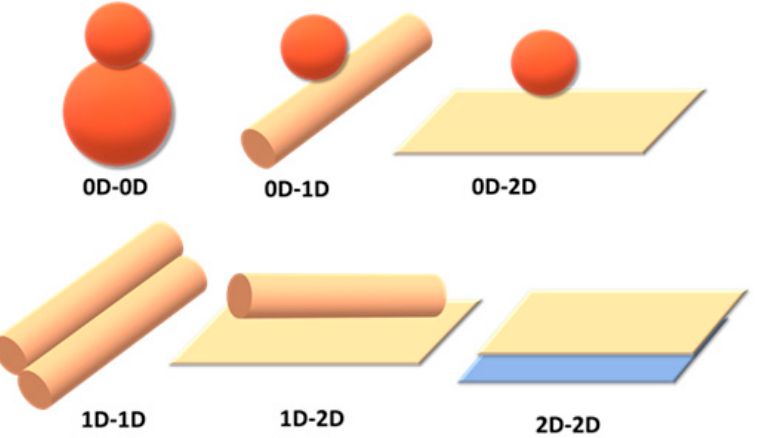
Figure 7. Schematic representations of various interfaces combining various dimensional mate–ri- als.